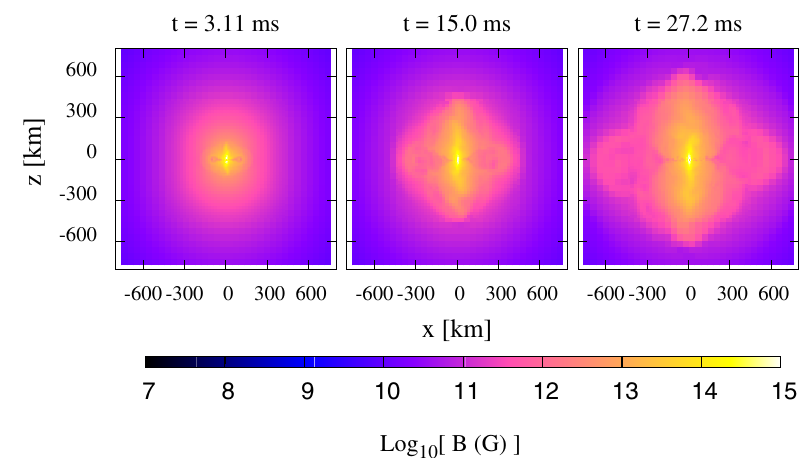
Fig. 39 Snapshots, at select times, of the magnetic field strength on a the x − z (meridional) plane for the case with magnetic field strength 1 . 7 × 10 14 G evolved in full 3D dimensions. Image reproduced with permission from Kiuchi et al. 2012, copyright by